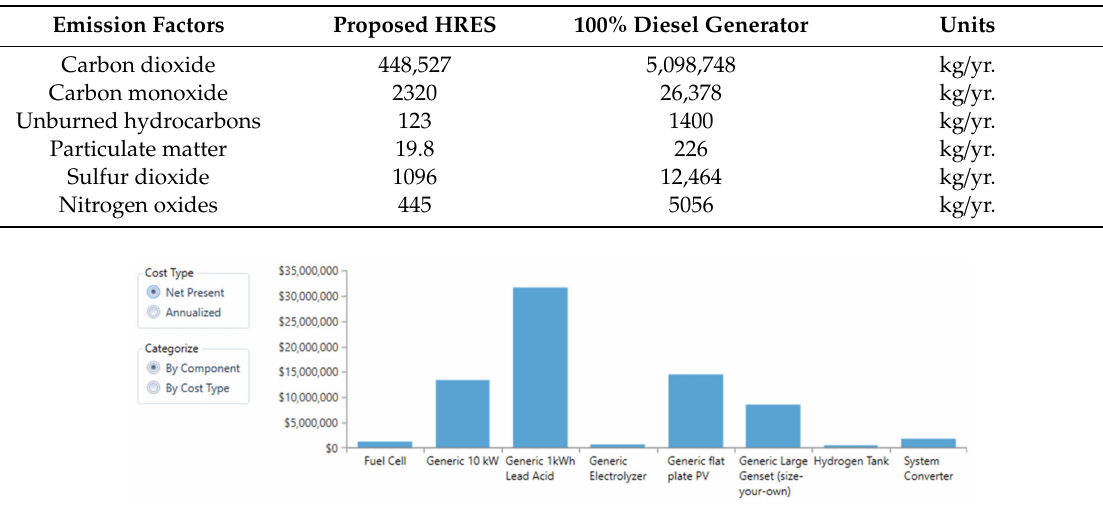
Figure 11. The cost summary of system components. Table 6. Detailed costs of system